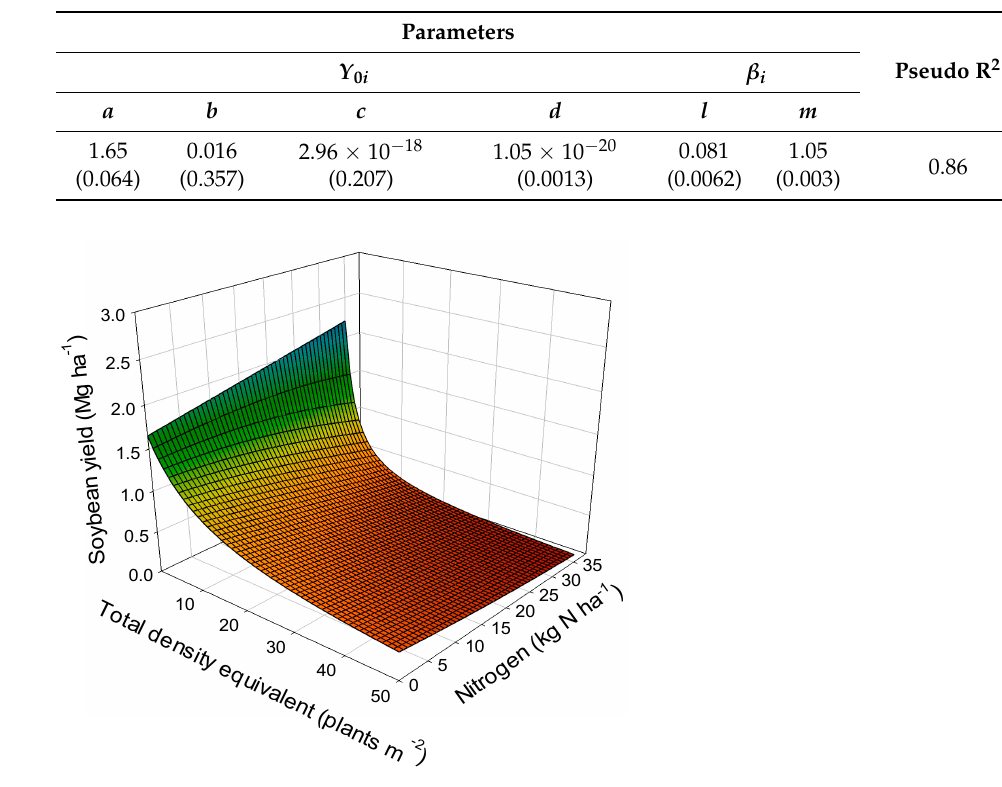
Table 4. Parameter estimates for the combined model for the regression of soybean yield as a result of multiple-weed interference expressed as the total density equivalent and applied nitrogen in the pooled two-year data. The numbers in parentheses are standard errors.